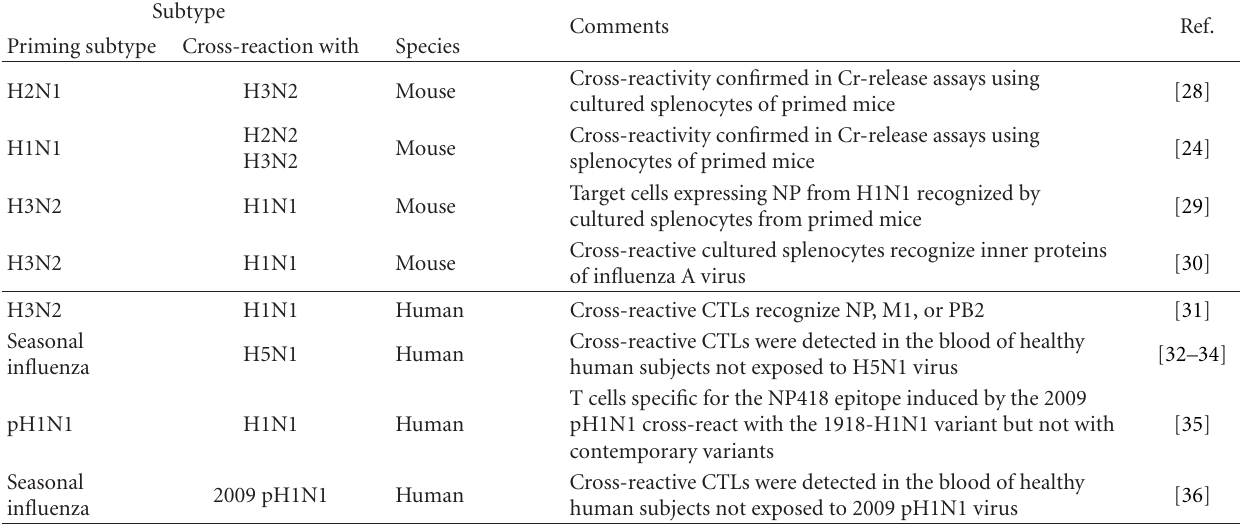
Table 1: Evidence for cross-reactivity of influenza virus-specific